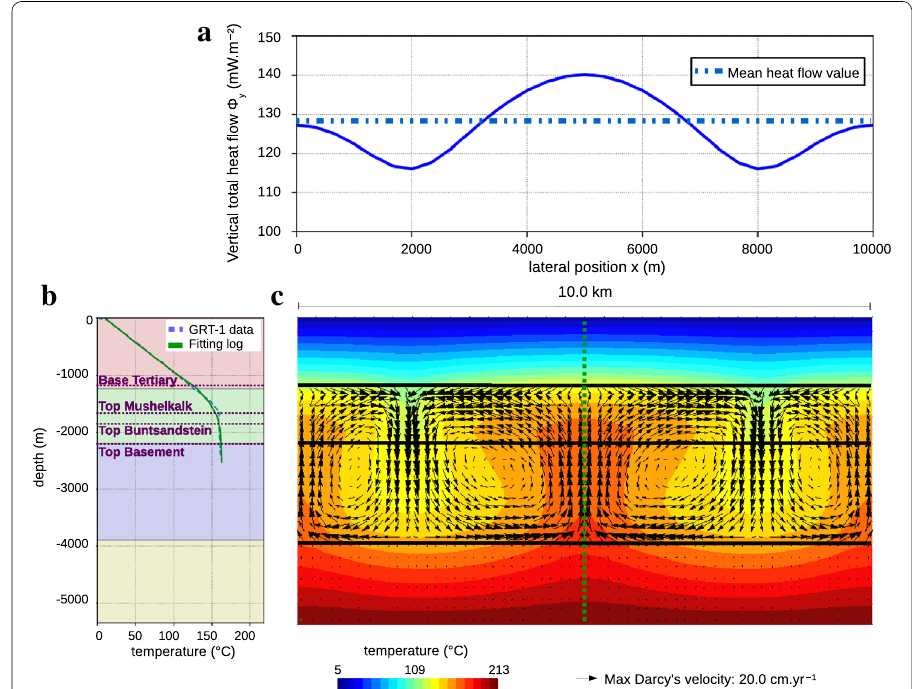
Fig. 3 a Profile of the vertical surface heat flow along the x -axis. The dotted line corresponds to the mean value of the heat flow. b Comparison of the simulated temperature profile obtained at the middle of the Rittershoffen mesh grid and the observed profile at GRT-1 well. The dotted lines correspond to the well-known lithological transitions. c Maps of calculated temperatures (background colors) and Darcy’s velocities (black arrows). The green dashed line is the location of the simulated profile shown in the left. The black lines are the transitions between the four idealized